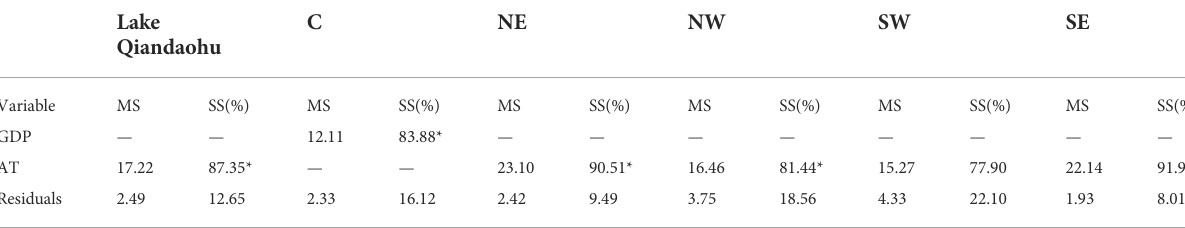
TABLE 1 Stepwise regression analysis results of the impacts of human and climatic factors on LSWT warming in Lake Qiandaohu and in each subsegment of the lake. Lake C NE NW SW Qiandaohu